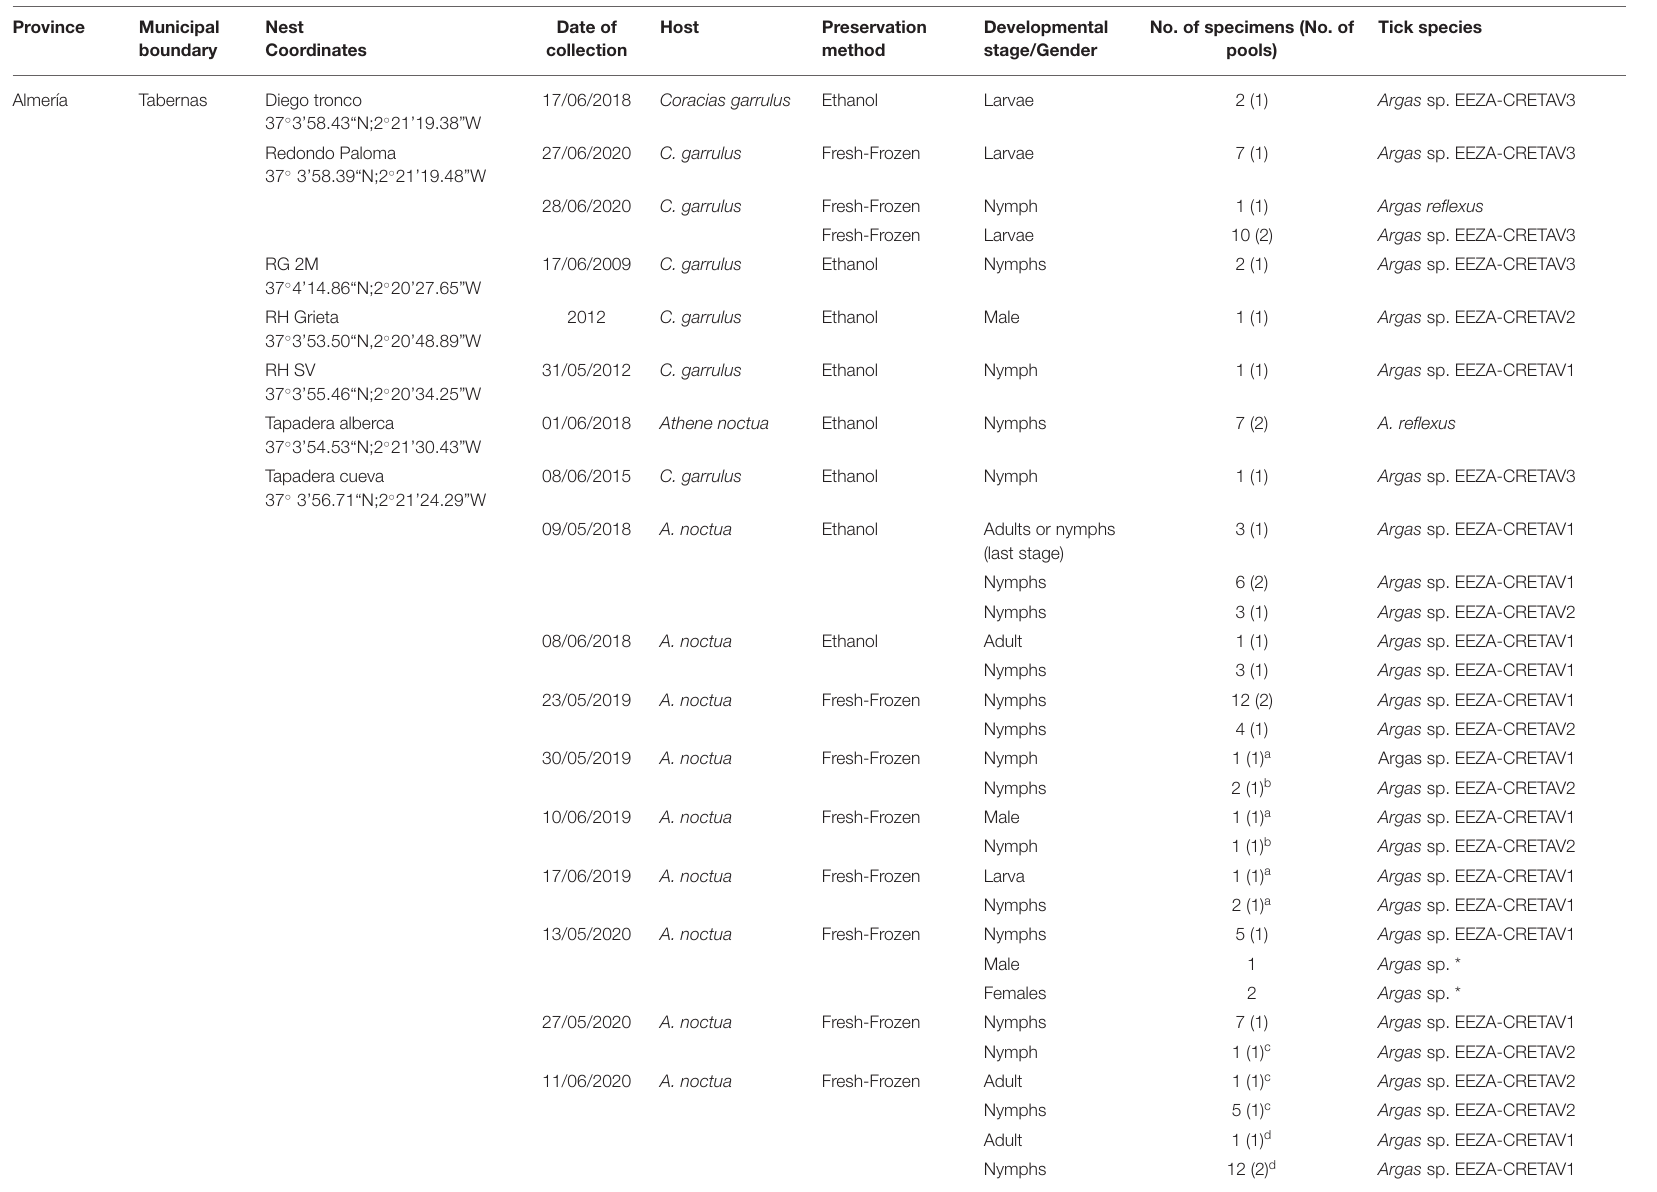
TABLE 1 | Tick samples used in this